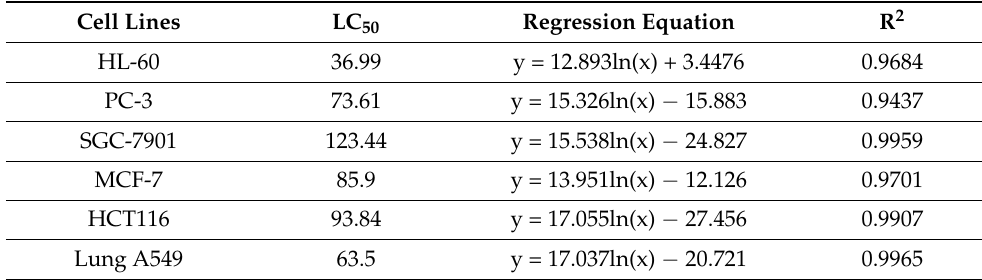
Figure 7. Absorbance ( A ), Percentage cell viability ( B ), and Percentage inhibition ( C ) against cancer cell lines at five different concentrations of PH-HM-10. Table 4. Regression analysis and IC 50 values of anticancer